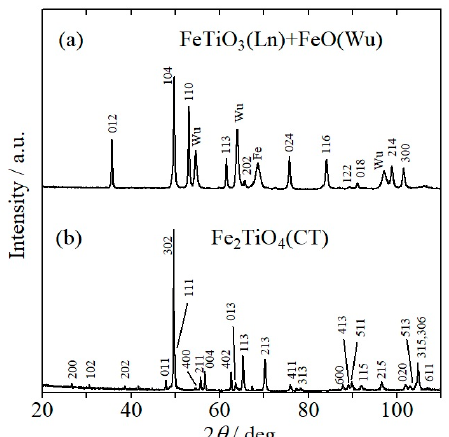
Figure 3. Powder X-ray diffraction patterns (Cr K α ) of run products of Fe 2 TiO 4 , ( a ) No. M150115 (14 GPa, 1100 °C) and ( b ) No. M140710 (18 GPa, 1300 °C). Miller indices in ( a ) are for Ln-type FeTiO 3 ,